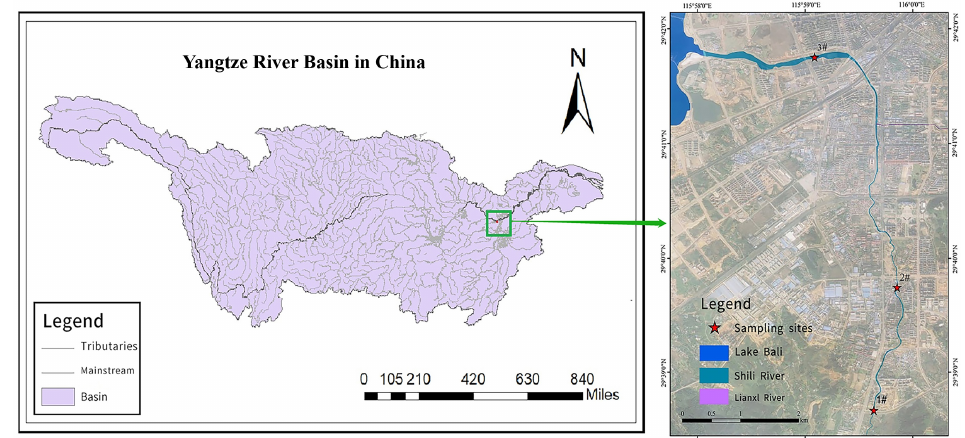
Figure 1. Distribution map of the Shili River Basin and sampling points .